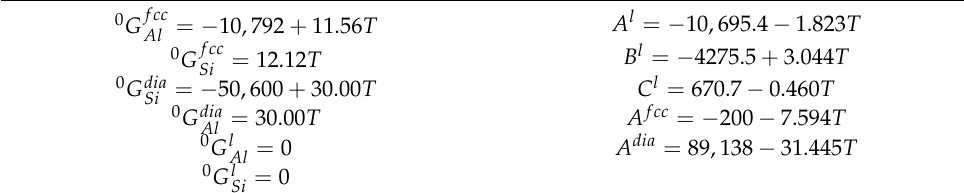
Table 2. Thermodynamic model parameters, J/mol, T in K [15,24]. 0 G fcc = − 10,792 + 11.56 Al